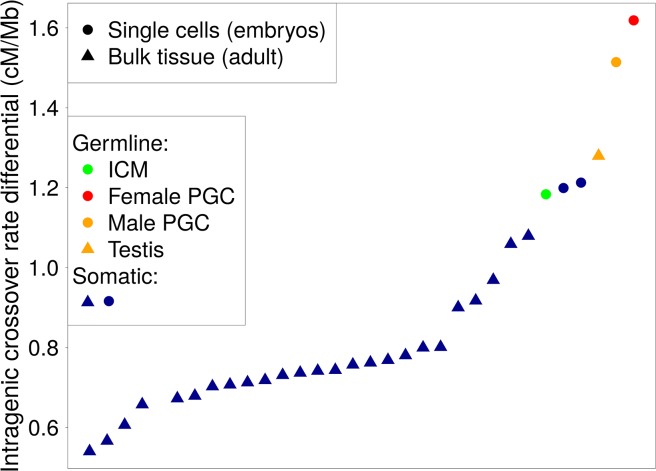
Differential intragenic crossover rate between lowly and highly expressed genes in adult tissues and in individual embryonic cells.This differential is computed as the difference between the mean sex-averaged intragenic crossover rates (HapMap) of lowly expressed genes (10% most lowly expressed for bulk tissue data or non-expressed genes for single cells data) and the mean of the 10% most highly expressed genes. Dots are ordered by increasing differential values. Rounded dots correspond to data from individual embryonic cells (Guo et al., 2015) and triangles to adult tissues (Fagerberg et al., 2014). Dark blue dots: somatic adult tissues and somatic embryonic cells are in dark blue. Orange dots: male testis tissue and primordial germ cells (between 4 and 19 weeks). Red dot: female primordial germ cells (between 4 and 17 weeks). Green dot: inner cell mass ICM of the blastocysts.